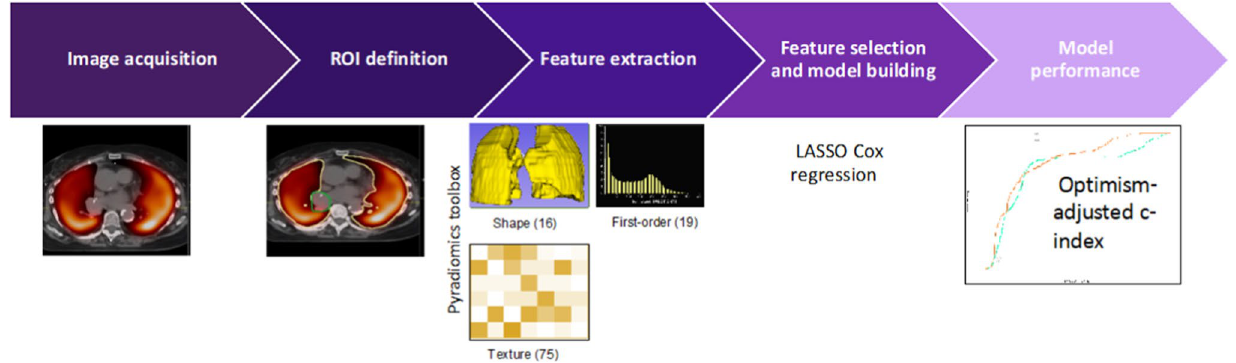
Fig. 1 Functional lung radiomics and machine learning pipeline for pneumonitis risk